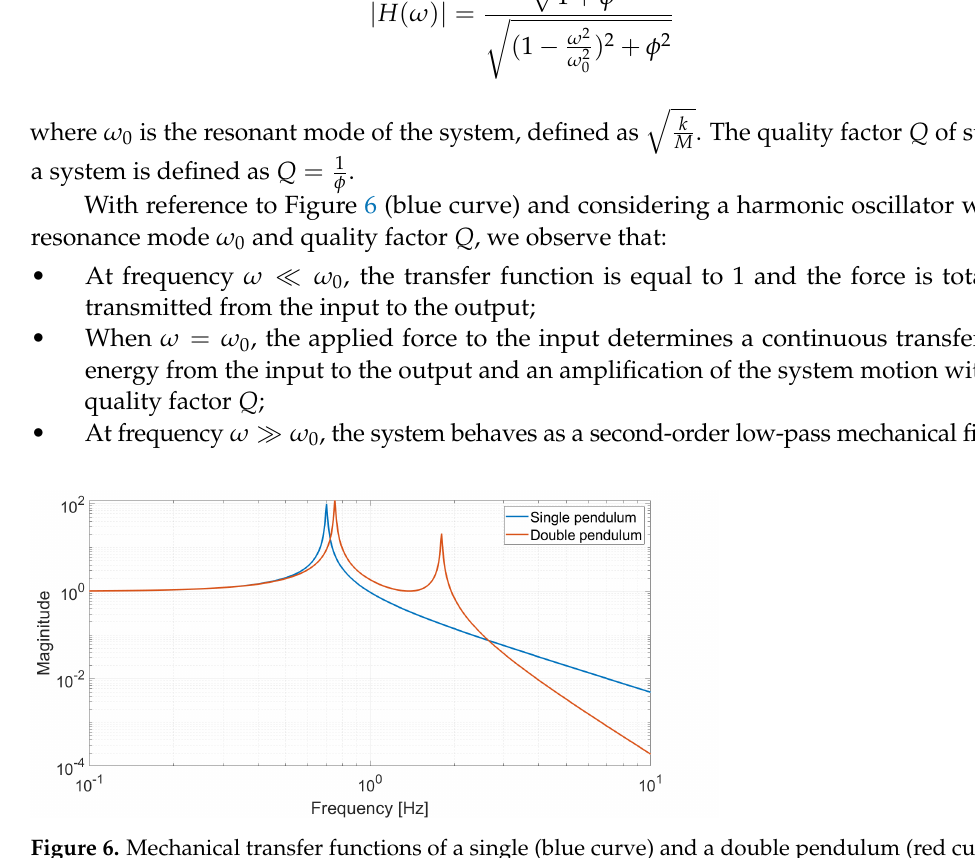
Figure 6. Mechanical transfer functions of a single (blue curve) and a double pendulum (red curve) having the same